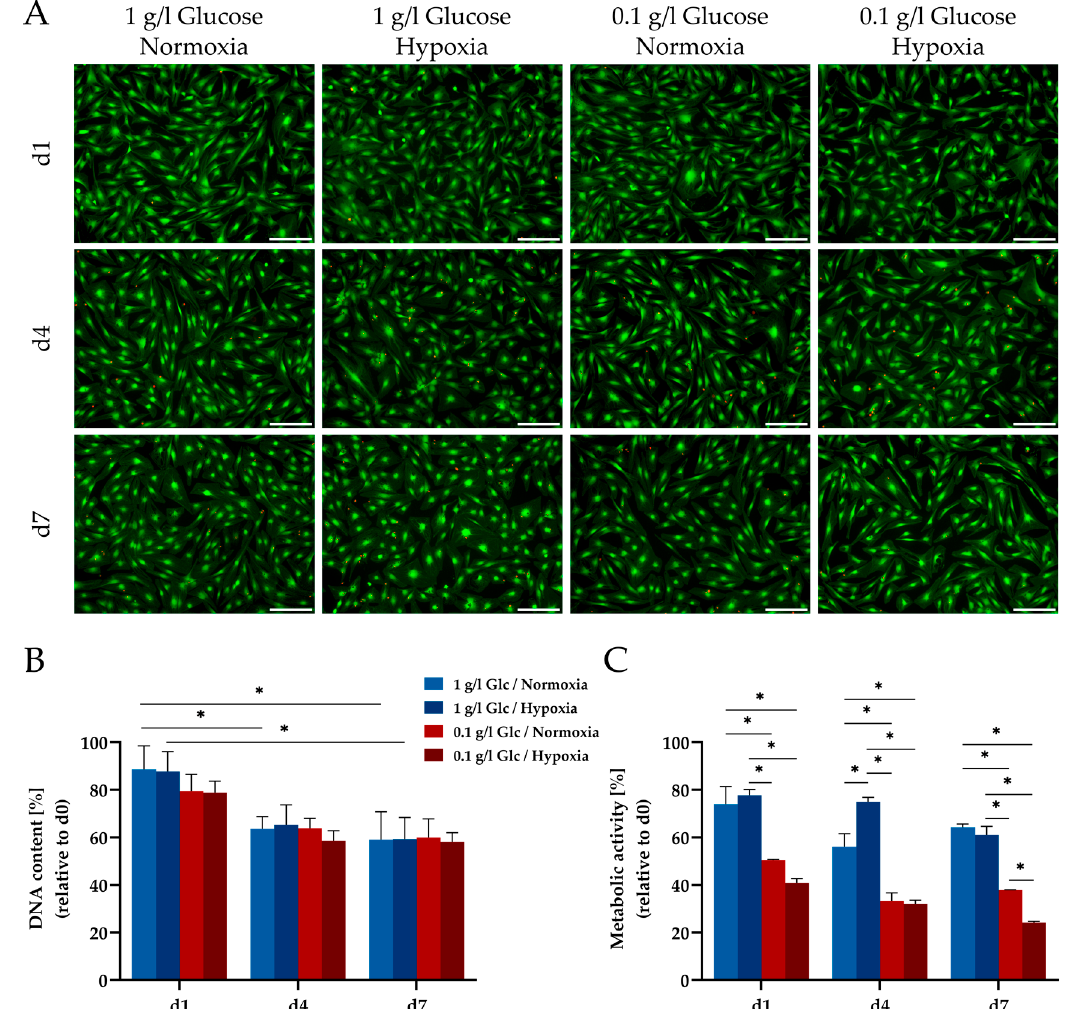
Figure 1. Viability and metabolic activity of human adipose-derived stromal/stem cells (ASCs) under glucose and oxygen deprivation. ( A ) Microscopic images of live/dead staining. Twenty five thousand cells per cm 2 were seeded in well plates and imaged at the indicated time points. Living cells were stained with calcein (green) and dead cells were stained with ethidium bromide (red). Scale bar represents 200 μ m. ( B ) Quantitative determination of total DNA content in relation to the mean value of day 0. ( C ) Metabolic activity as determined by a MTT assay. MTT accumulated in ASCs was solubilized and the optical density was measured at 570 nm; % metabolic activity was calculated in relation to the mean value of day 0. Data are presented as means ± SD of n = 3; * p < 0.05. Abbreviation: MTT: 3-(4,5-dimethylthiazol-2-yl)-2,5-diphenyltetrazolium bromide.